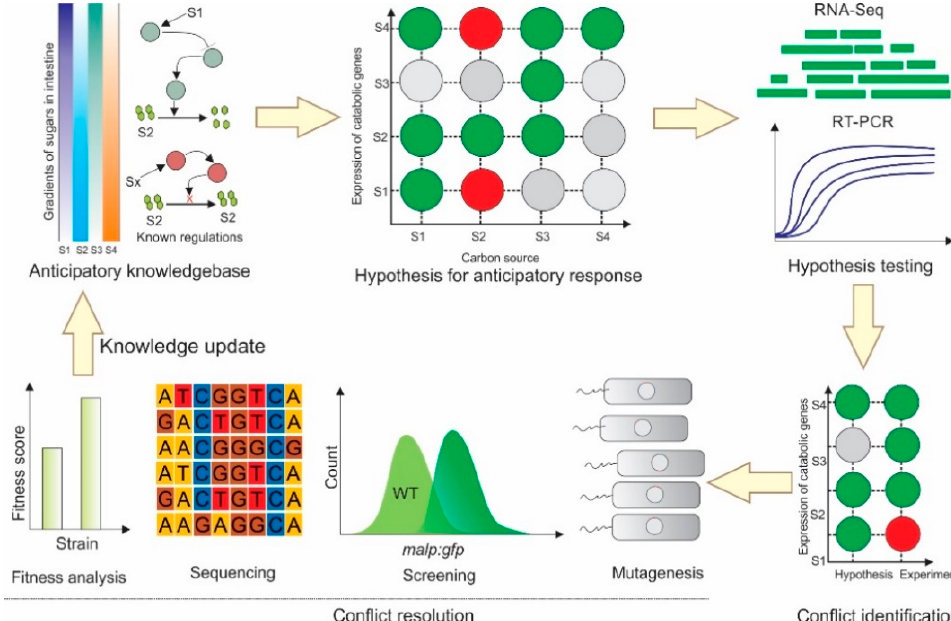
Figure 1 . Overview of the hypothesis and validation of anticipatory responses in E. coli MG1655 for carbon sources that have spatial abundances in the mammalian intestine.